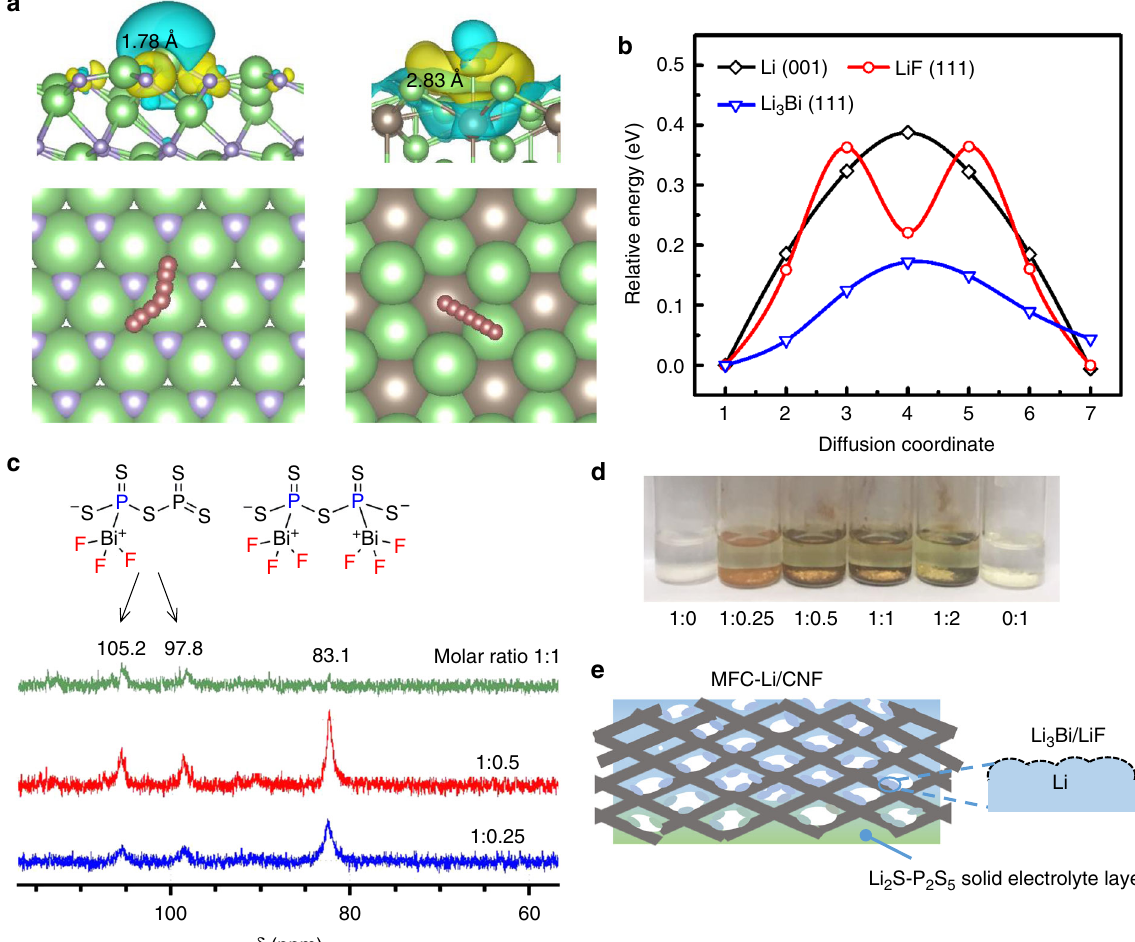
Fig. 2 Coating Li by solubilized BiF 3 . a Charge density difference plots showing the adsorption of a Li adatom on the substrate of LiF (111) (left) and Li 3 Bi (111) (right) (top row); the diffusion pathways of Li adatoms on the corresponding surfaces (bottom row). The green, purple and brown balls represent lithium, fl uorine and bismuth atoms, respectively. b Comparison of diffusion energy barriers on Li (001), LiF (111) and Li 3 Bi (111) facets. c The proposed reaction products of the complexation between BiF 3 and P 2 S 5 , and 31 P NMR solution spectra of the supernatants of BiF 3 and P 2 S 5 mixture at different molar ratios (BiF 3 :P 2 S 5 ) as labeled. d Photography of the mixtures of BiF 3 -P 2 S 5 with different molar ratios (BiF 3 :P 2 S 5 ) in DME. e A cartoon showing the coating strategy to derive